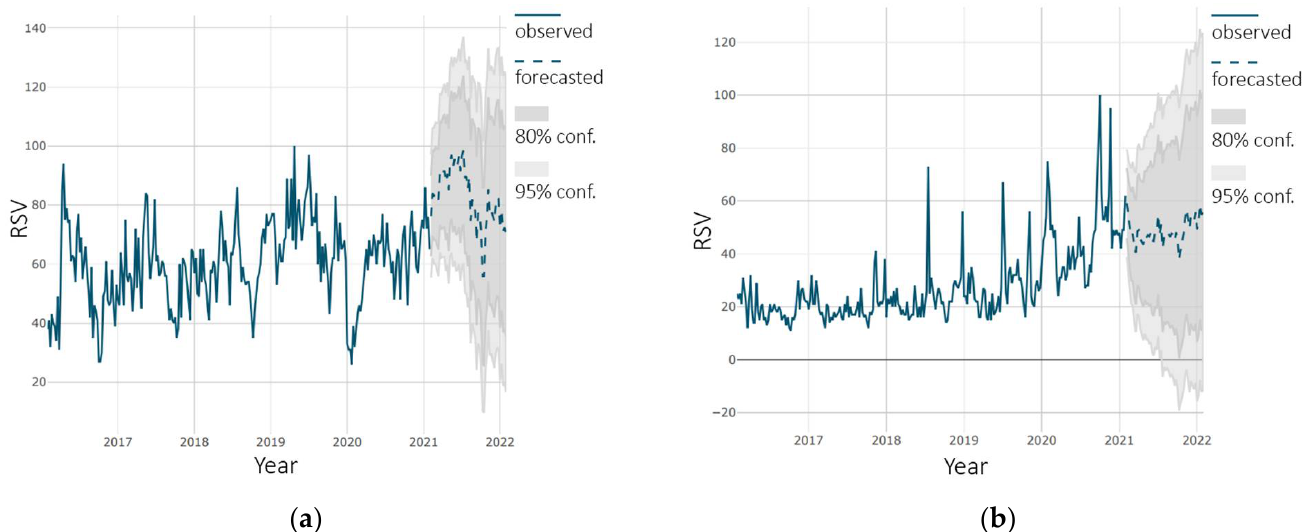
Figure 5. Forecast using Holt–Winters model of interest in: ( a ) “hpv” vaccine; ( b ) “polio” vaccine.